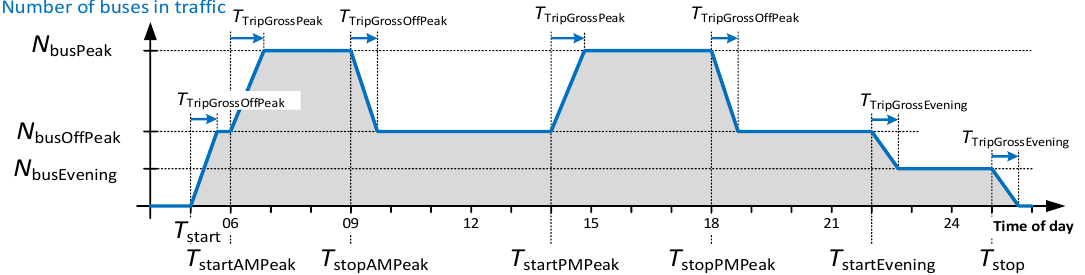
Figure 6. Number of buses in traffic during the day. Derived from the timetable and route parameters.